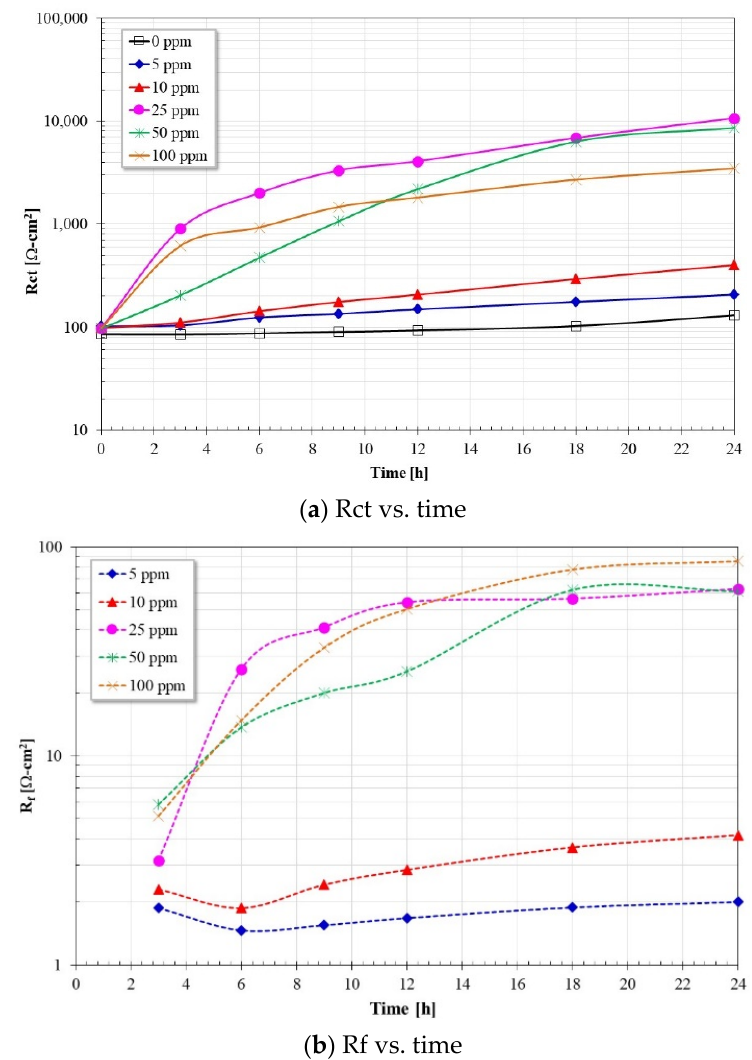
Figure 9. Rct and Rf values as a function of time and inhibitor concentration.